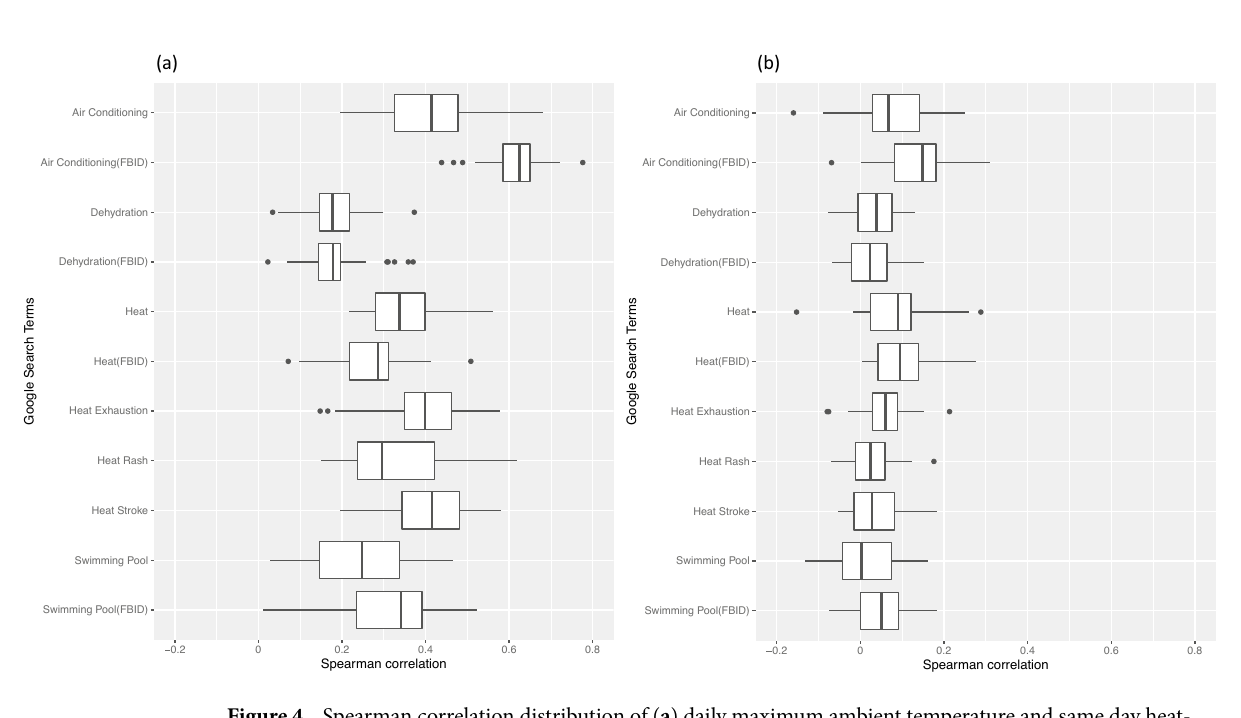
Figure 4. Spearman correlation distribution of ( a ) daily maximum ambient temperature and same day heat- health related Google searches and ( b ) heat-health related Google searches and same day heat-related ED visits across 30